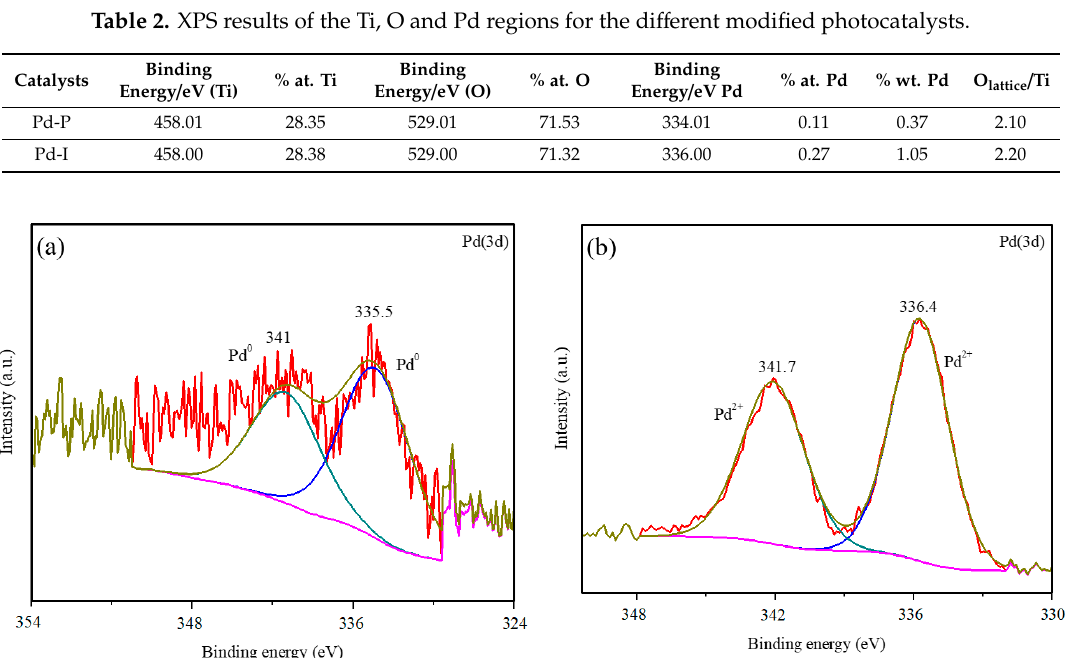
Table 2. XPS results of the Ti, O and Pd regions for the different modified photocatalysts .